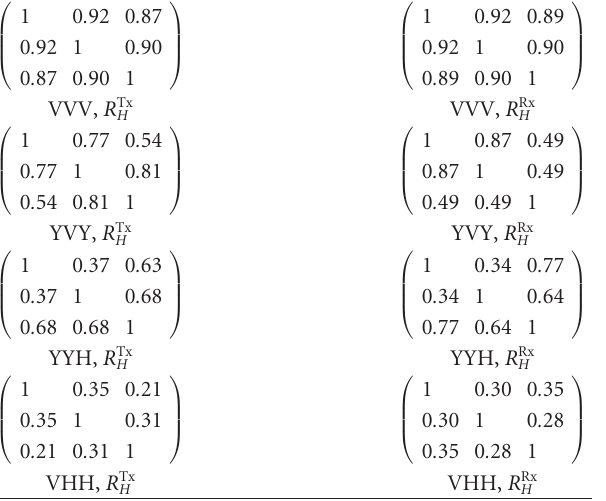
Table 5: Correlation matrix of direct path power analysis for di ff er- ent polarization schemes in NLOS environment.